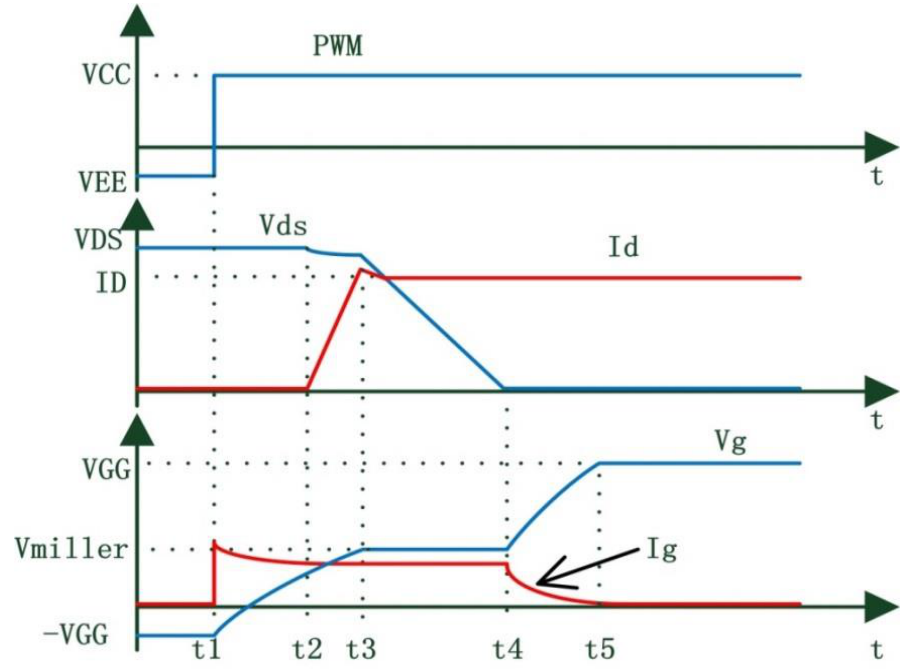
Figure 3. The general scheme of control method for the proposed time division shaped switching transitions.